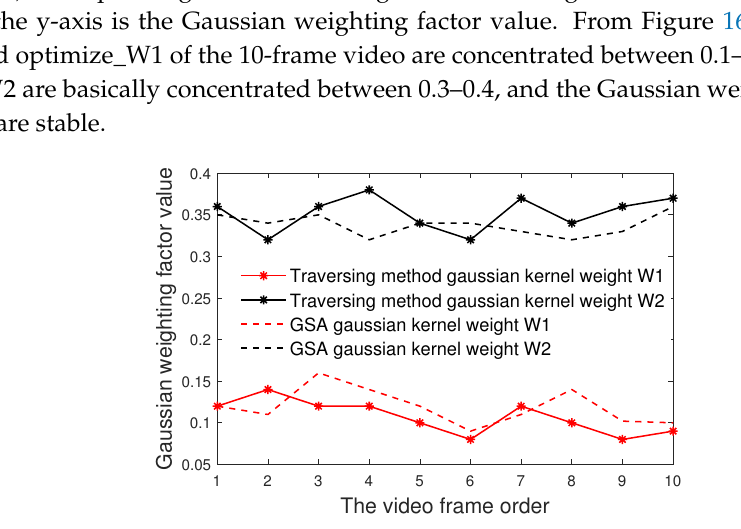
Figure 16. Traversal method and GSA algorithm used to optimize Gaussian weighting